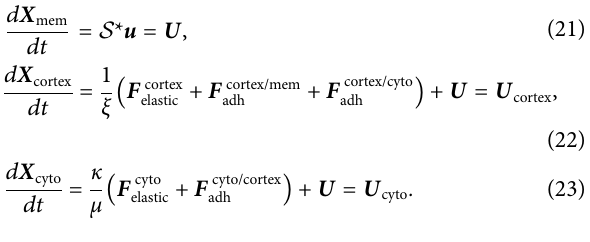
Table 1 lists the values of parameters for blebbing simulations. Most simulations in the Results section use a value of 20 pN/ μ m for membrane stiffness, 500 Pa for k cyto , and 1 · 10 – 2 µm 2 for permeabilty.